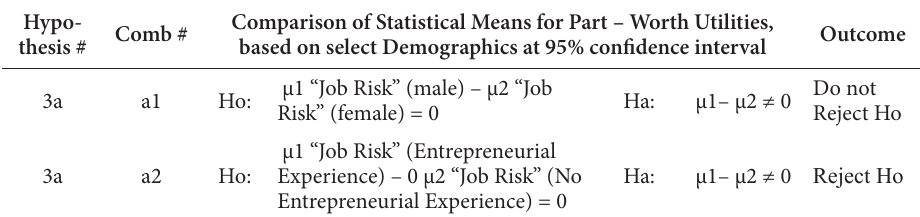
Table 4. Hypothesis 3a